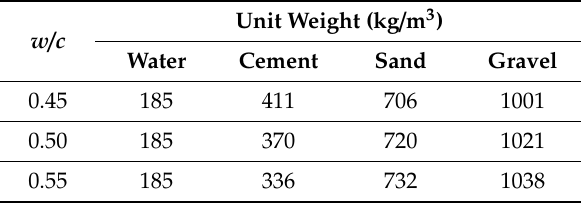
Table 3. Mixing proportion of the